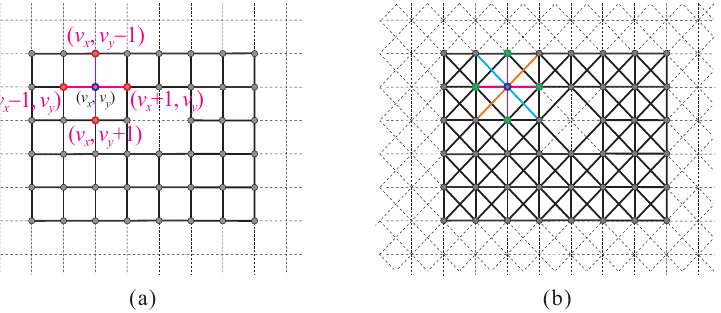
Figure 2. ( a ) A grid graph and ( b ) a supergrid graph, where the circles represent the vertices and the solid lines indicate the edges in the